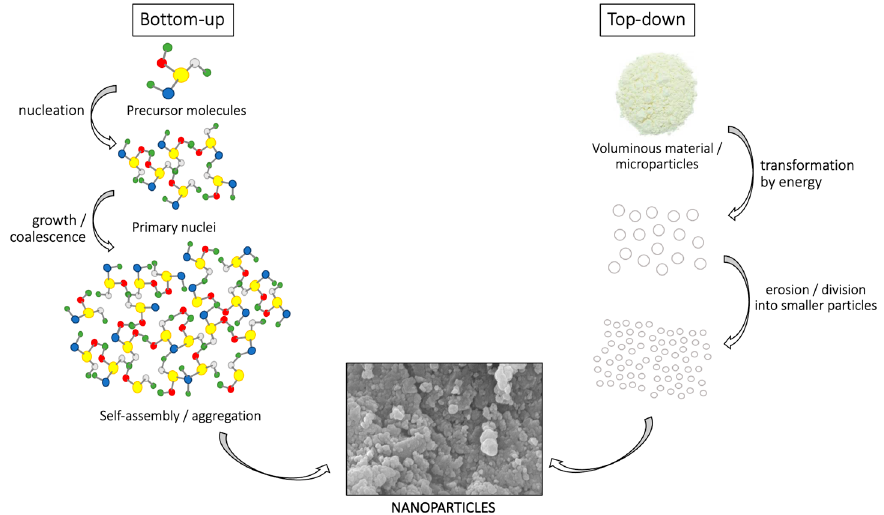
Figure 1. Top-down and bottom-up processes for the synthesis of the SNPs.